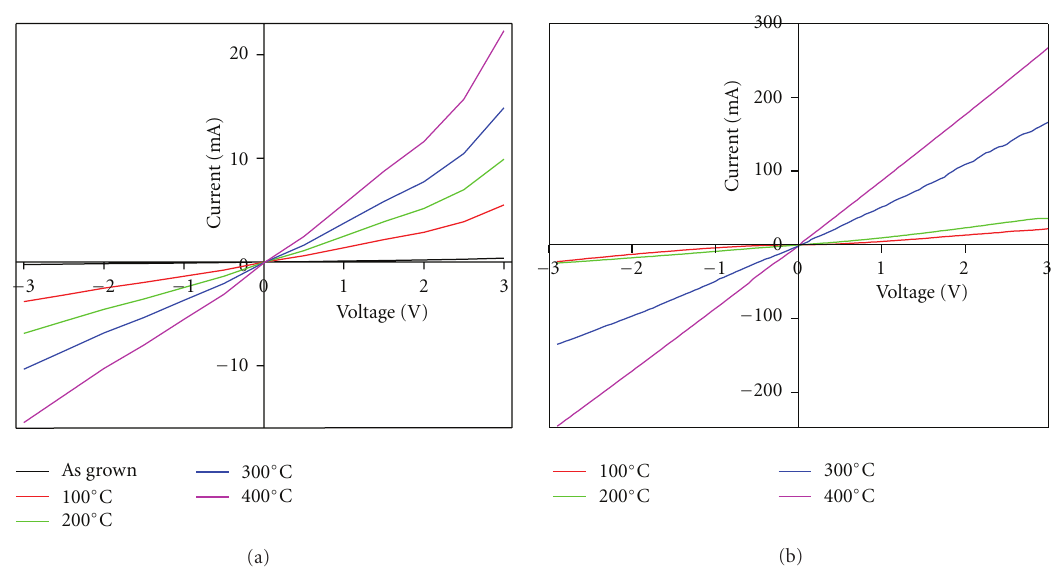
Figure 7: I - V response of as grown and annealed thin films of Ag-doped nanostructured CdS under (a) dark and (b) illumination to 100mW/cm 2 light